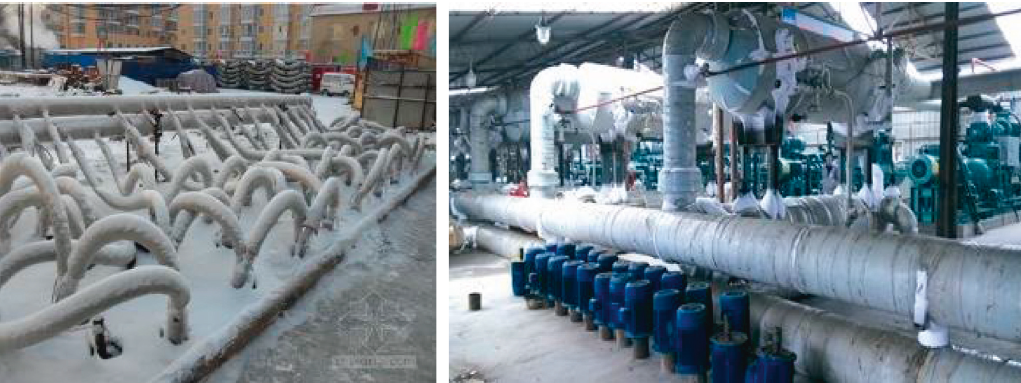
Figure 1: Construction site of AFM